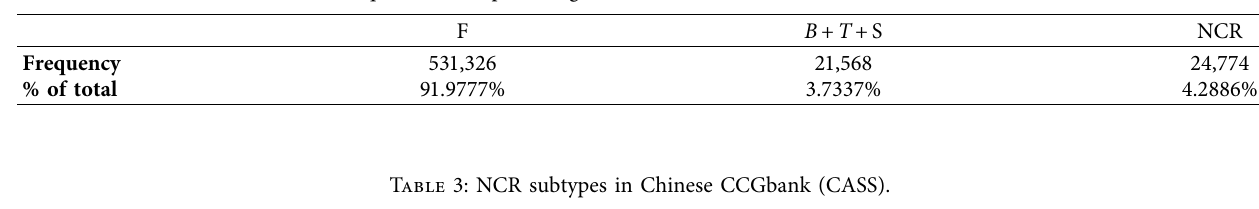
Table 2: Frequencies and percentages of rules utilized in Chinese CCGbank (CASS).